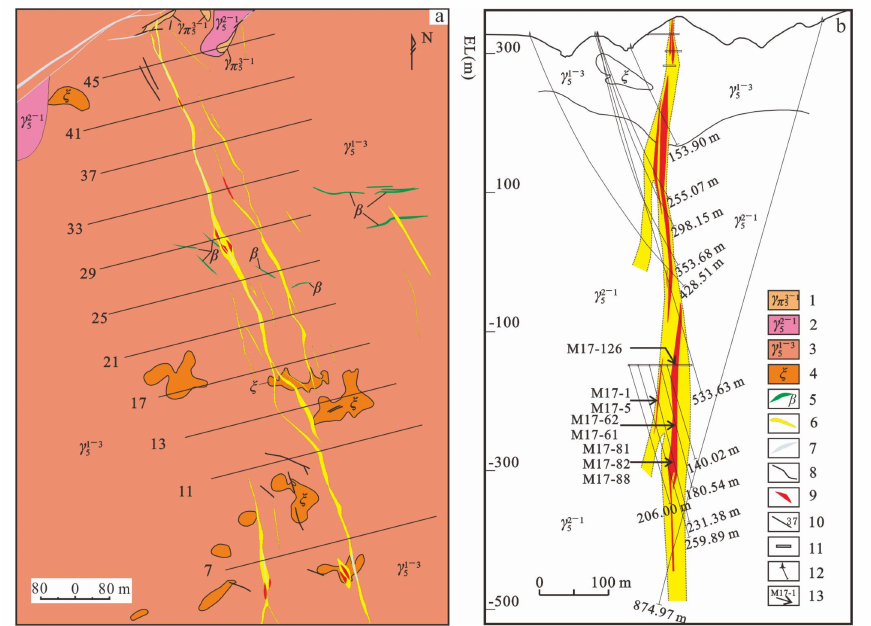
Figure 2. Sketch geological map ( a ) and exploration section ( b ) of the Mianhuakeng deposit. 1— Granite porphyry; 2—Medium-coarse-grained porphyritic biotite monzonitic granite; 3—Medium- fine-grained biotite-muscovite granite; 4—Syenite; 5—Diabase; 6—Structure alteration zone; 7— Silicified belt or Siliceous veins; 8—Fault; 9—Uranium ore body; 10—Exploration line and number; 11—Underground tunnel; 12—Drill hole; and 13—Sample